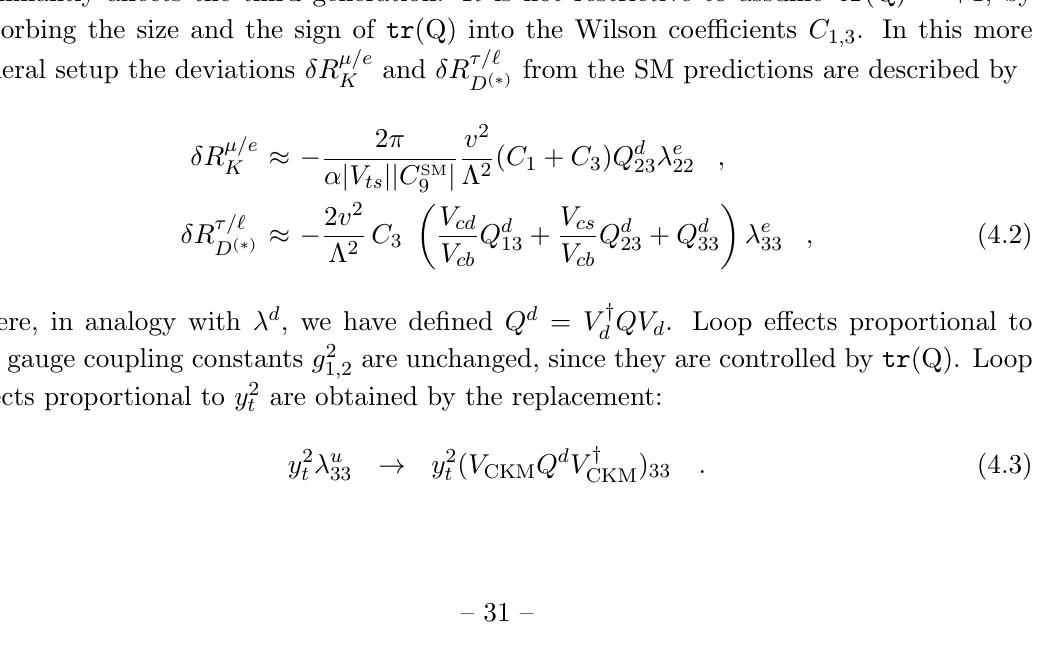
where Q and L are hermitian matrices in (cid:13)avour space and generation indices are